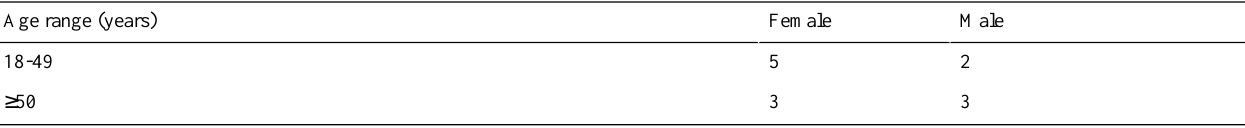
Table 2. Cross-tabulated table for the sample stratification by sex and